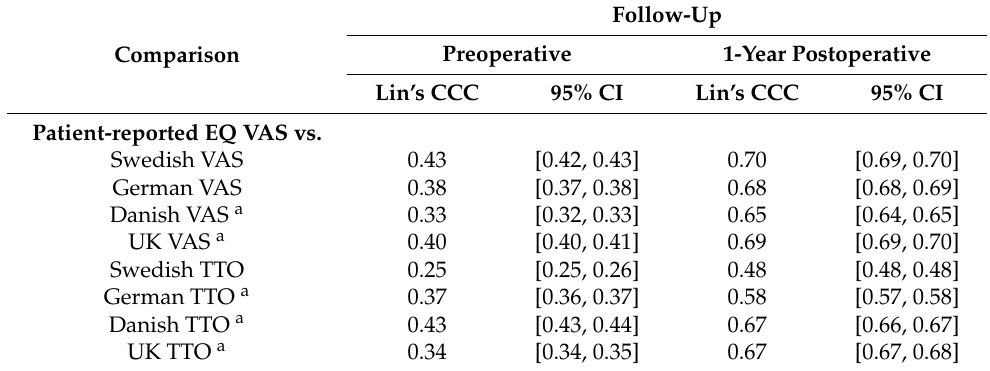
Table 3. Lin’s CCC tests between patient-reported EQ-VAS and EQ-5D-3L indices based on the value sets pre- and 1 year postoperatively ( n = 73,523).